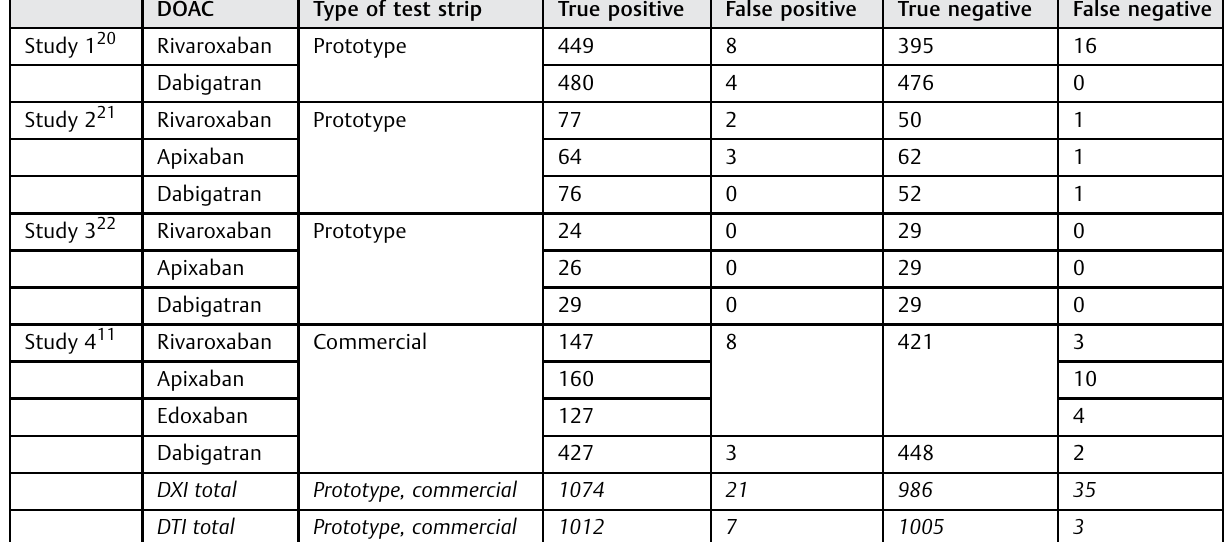
Table 2 Data used for pooled analysis and